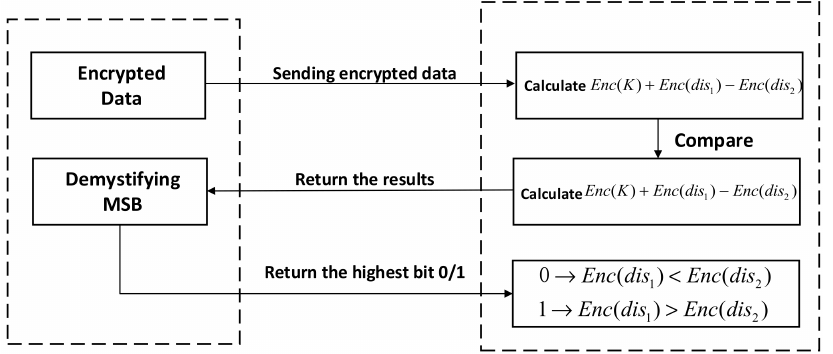
Figure 6. User-server interaction